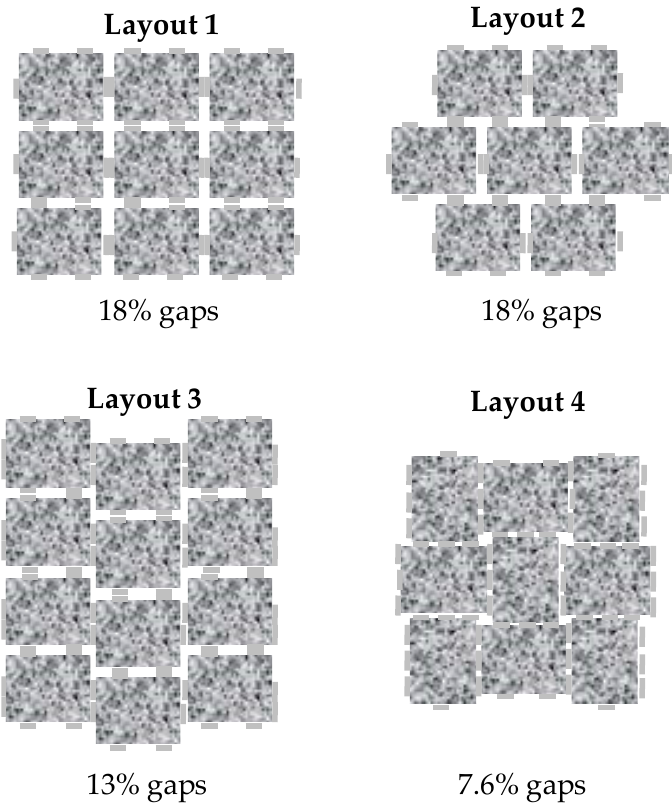
Figure 6. Permeability vs block pattern.